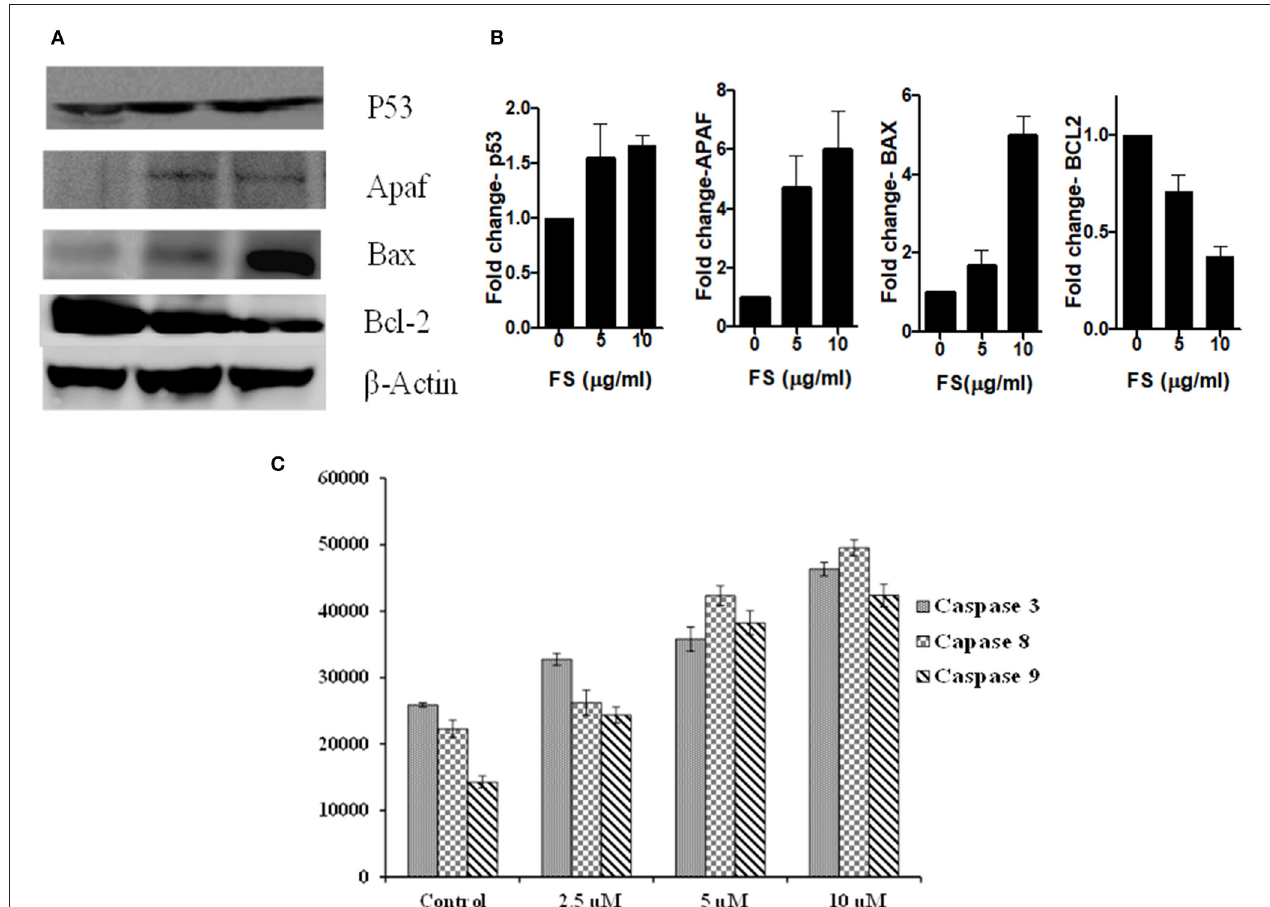
FIGURE 5 | (A) Representative Western blots showing expression patterns of p53, Apaf, Bax, Bcl2, and β -Actin in FS treated A549 cells. (B) Bar diagram represent the relative protein quantification of Apaf-1, Bax, Bcl2, and p53, normalized to beta-actin. Data are presented as the mean ± SEM, n = 3. (C) Caspase-3, caspase-8, and caspase-9 activities were evaluated using caspase fluorometric assay kits (promega). Caspase activities were carried out using a fluorogenic caspase substrate measured with a fluorimeter. Data are the means ± SD of three independent